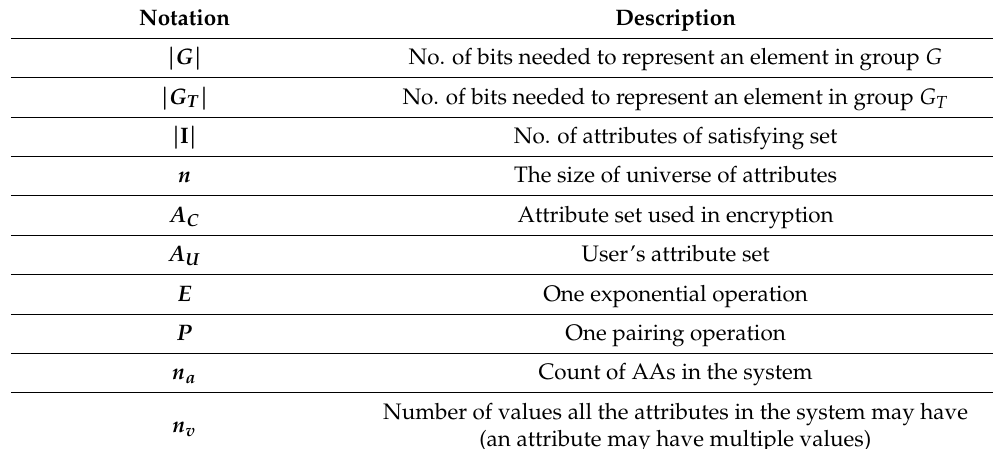
Table 3. Summary of